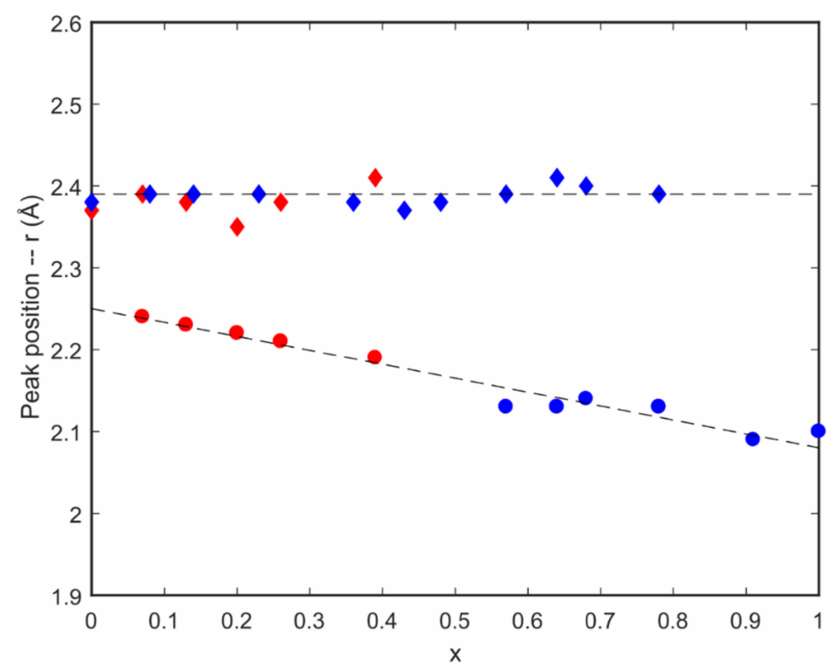
Figure 2. Peak positions of the first Mg-O and Ca-O correlations, taken from Supplementary Ma- terials Figures S3 and S4, Where x is the proportion of magnesium in the sample as given by: (Ca 1 − x Mg x )CO 3 . The data shown as red markers are from this study (Figure S4), and the blue markers from [31] (Figure S3). Filled diamond symbols denote the first Ca-O correlation peak around 2.4 Å; Filled circle symbols denote the first Mg-O correlation peak around 2.1–2.2